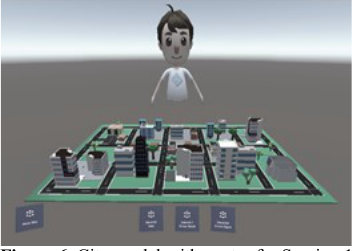
Figure 6. City model with avatar for Session 1.